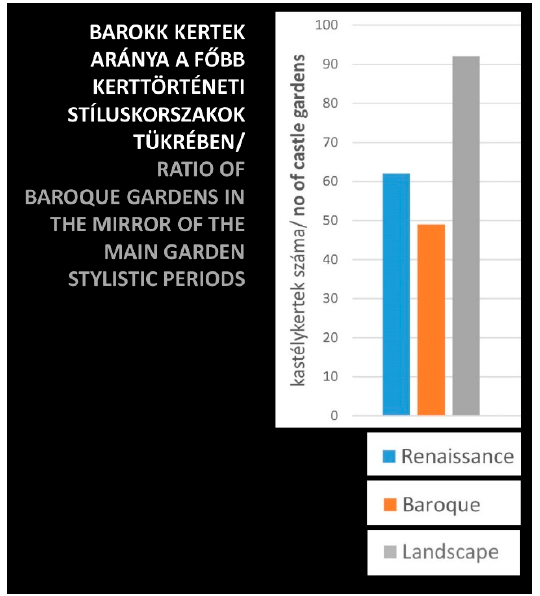
Figure 10. The number of Renaissance, Baroque and Landscape Gardens in Transylvania. Source: compiled by Albert Fekete.